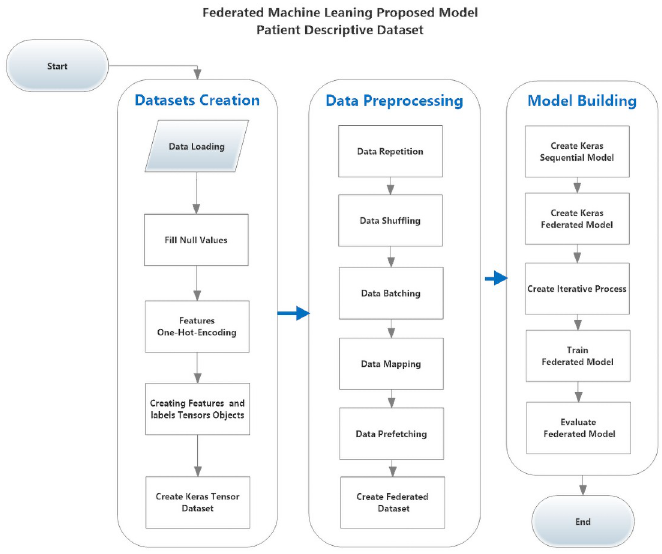
Fig 3. The proposed federated model for classifying COVID-19 cases from patient’s descriptive data.